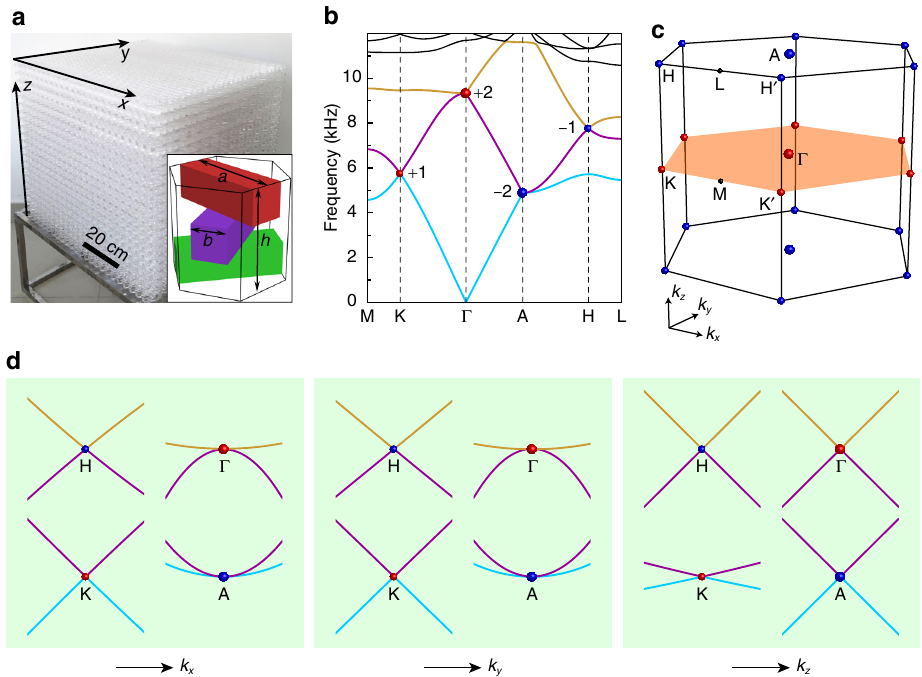
Fig. 1 3D chirally stacked acoustic metacrystal with multiple Weyl points. a An image of the sample and its unit-cell geometry. b Band structure calculated along several high-symmetry lines, where the color spheres highlight the differently charged topological nodes provided by the lowest three bands (color lines). c Bulk BZ of the metacrystal. d Local dispersions simulated around the four nodal points, revealing clearly the quadratic dispersions near the QWPs Γ and A , along the k x and k y directions, in contrast to the CWPs K and H crossed linearly along all directions.